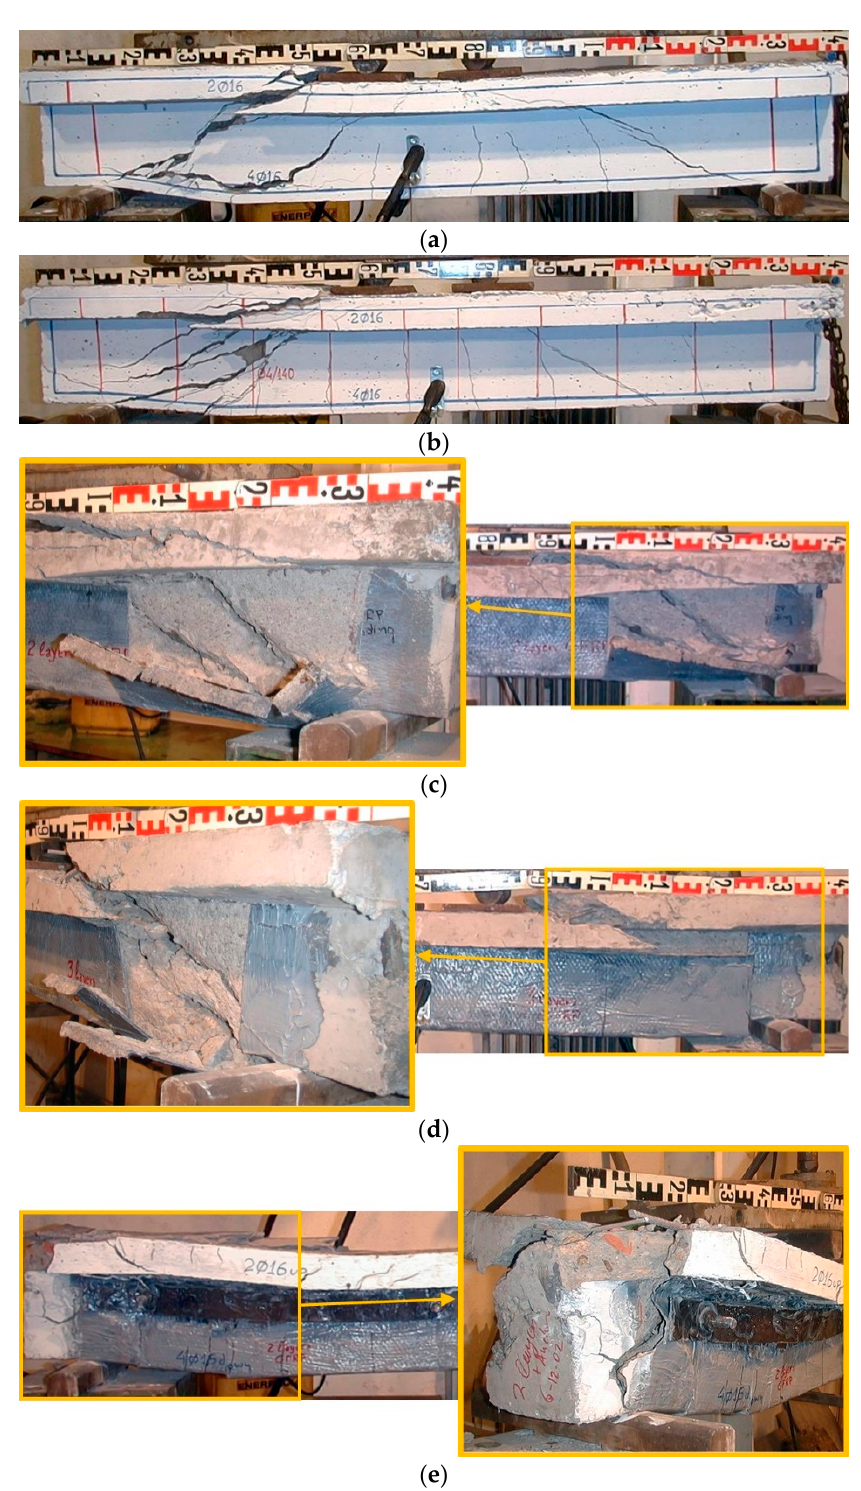
Figure 3. Cracking and shear failure of the tested beams: ( a ) T; ( b ) TS; ( c ) T2J; ( d ) T3J; ( e ) T2J-A. The total applied load at shear cracking ( P cr ) and the corresponding midspan deflection ( δ Pcr ), as well as the ultimate applied load ( P u ) and the corresponding midspan deflection ( δ Pu ) as